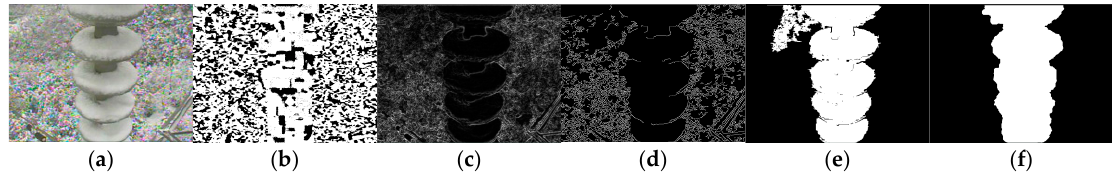
Figure 7. Experiments of six image segmentation methods for ice-covered insulator, ( a ) original images, ( b ) threshold method, ( c ) Sobel, ( d ) Canny, ( e ) seed region growth method, ( f ) GrabCut.